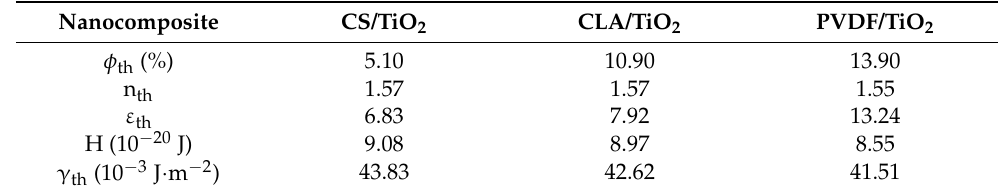
Table 8. Corresponding threshold ε th , n th , H and γ th for θ = 89.9 ◦ of CS/TiO 2 , CLA/TiO 2 and PVDF/TiO 2 nanocomposites.